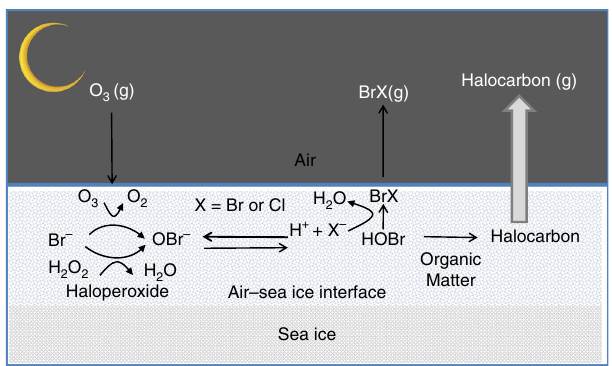
Fig. 3 Schematic of the possible release mechanisms of bromocarbons from sea ice in the Antarctic